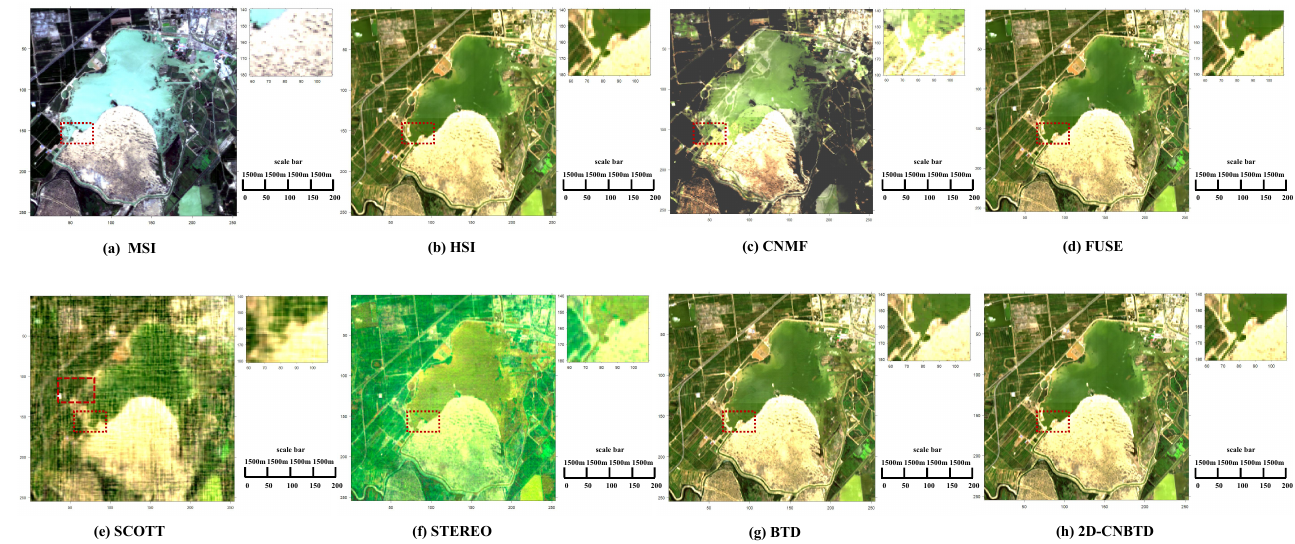
Figure 11. Map of fusion image of Ningxia Sand Lake